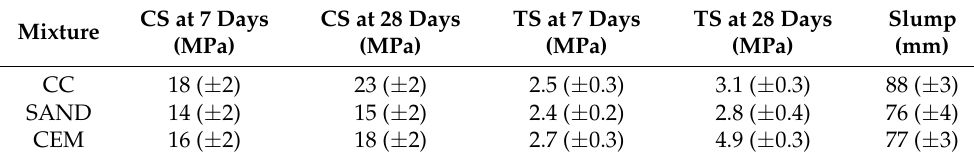
Table 2. Experimental results of slump, compressive and tensile (cylindrical compression) strengths at 7 and 28 days for the three distinctive concrete specimens